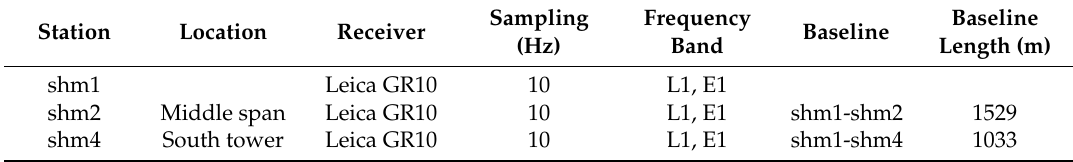
Table 1. The detailed information of the two baselines.